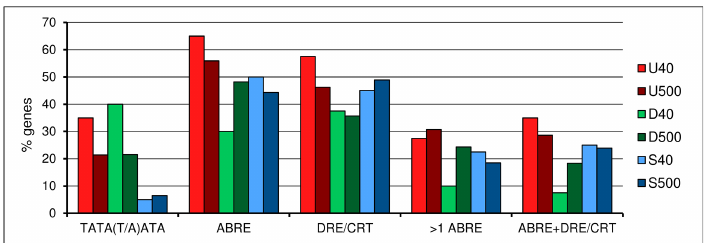
Fig 5. Percentage of genes with which putative promoter region contain consensus TATA box, ABRE, and/or DRE/CRT motifs. Statistical significances from pairwise comparisons are providedin Table B in S1